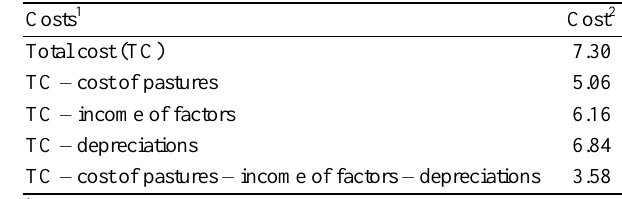
Table 3. Total and discounted production costs (in BRL for kg of